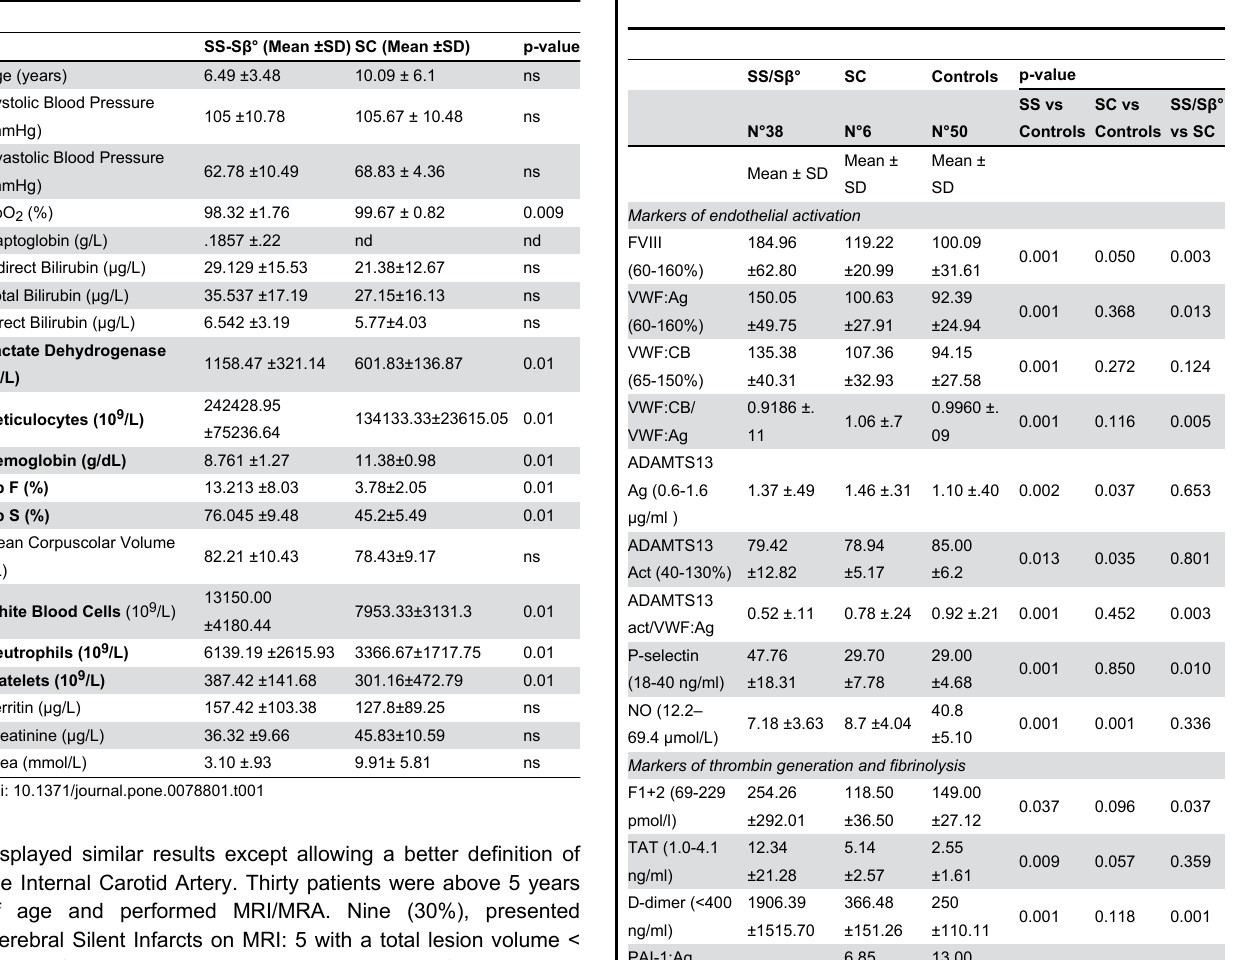
Table 1. Hematological Values of 38 children with SS-Sβ° and 6 with SC Sickle Cell Disease.